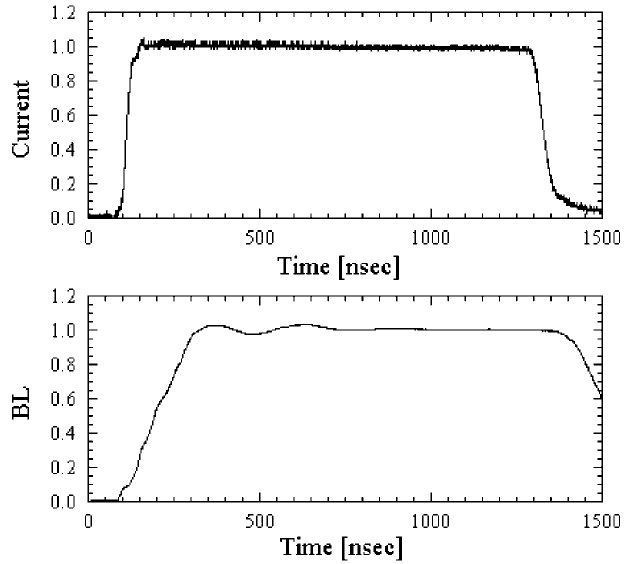
FIG. 4. Output current and integrated magnetic field, which are normalized by the average value of the flattop. The upper graph shows the output current measured by the current monitor, Pearson Electronics, Inc. model 110, which is installed at a load cable. The lower graph shows the integrated magnetic field measured by the search coil.